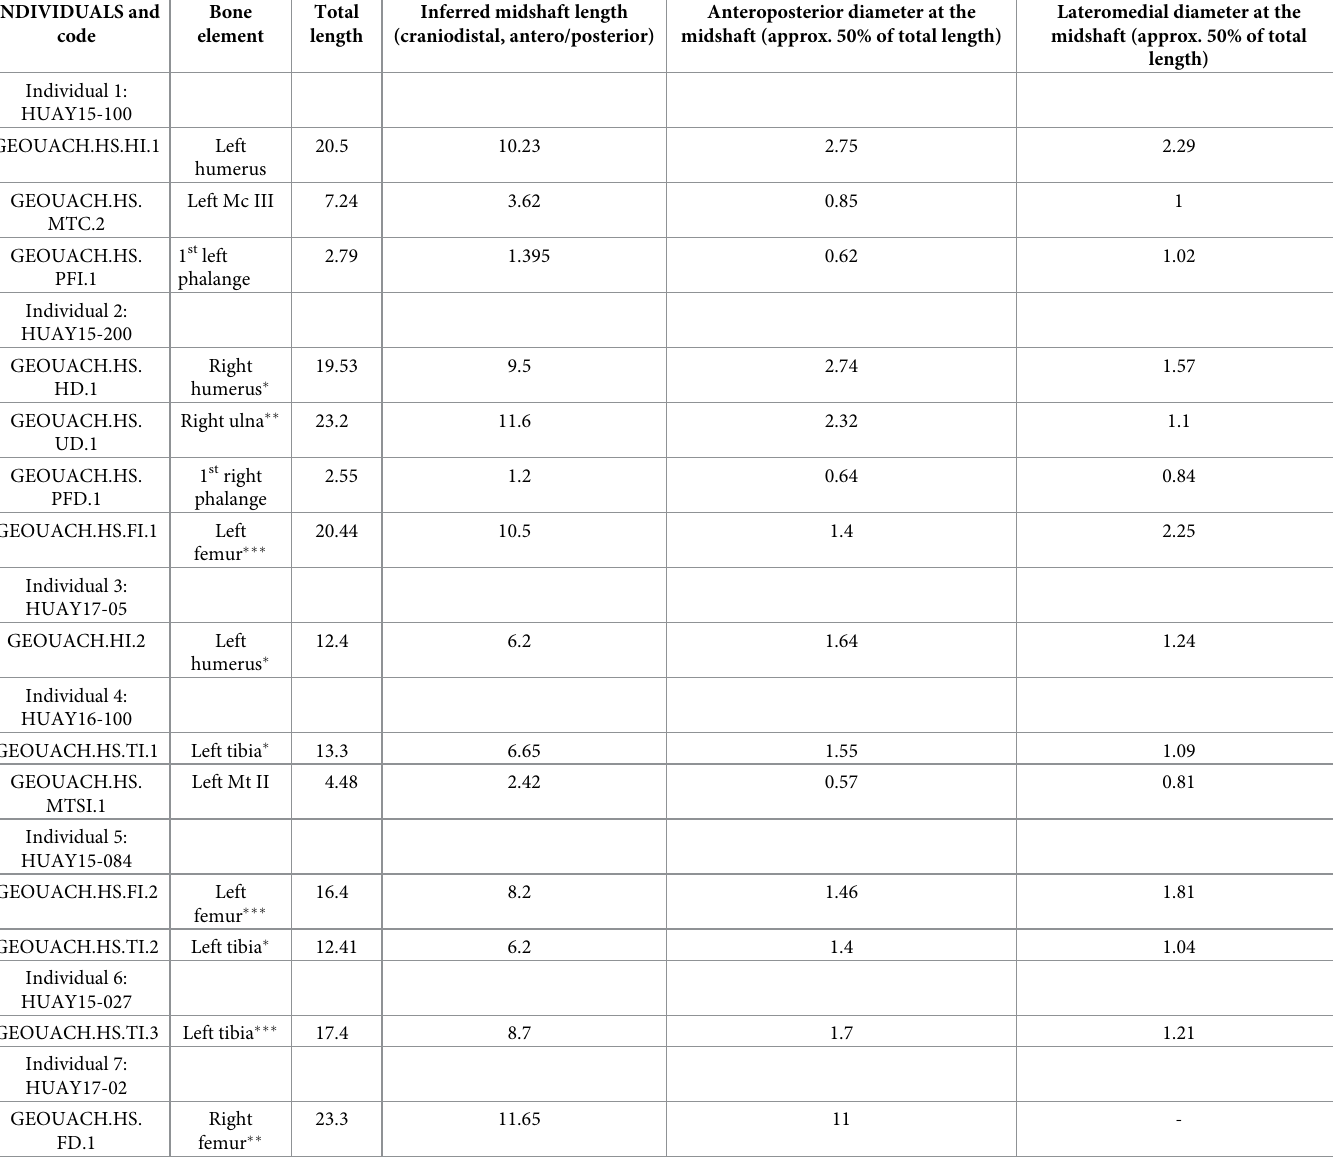
Table 1. Bone measurements (cm) of seven individuals of Caraguatypotherium munozi from Huaylas formation. INDIVIDUALS and Bone Total Inferred midshaft length code element length (craniodistal, antero/posterior)